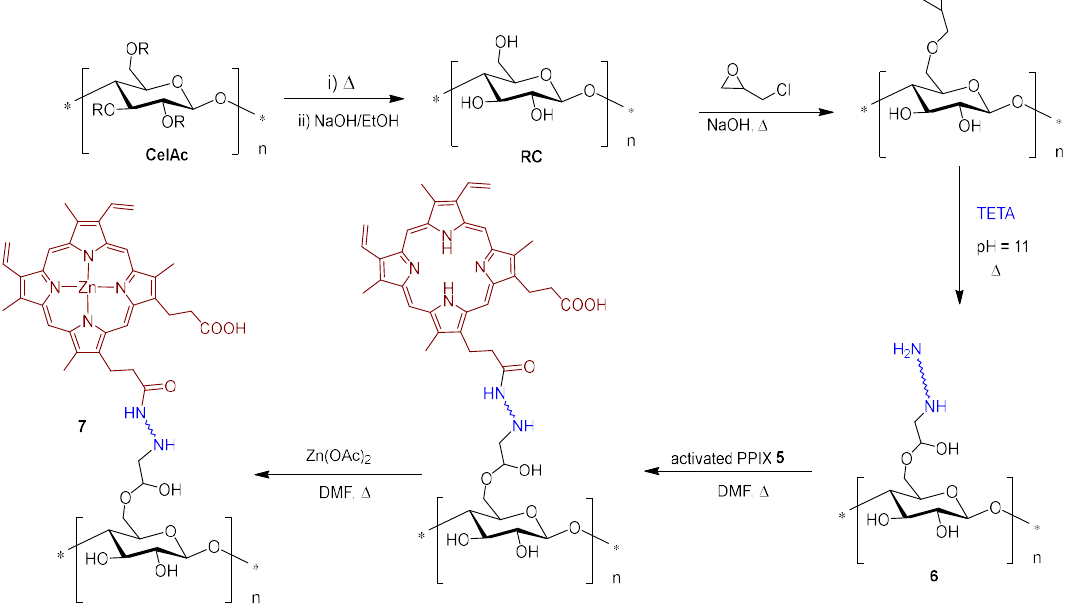
Figure 6. Covalent grafting of activated PPIX 5 using epichlorohydrin functionalized cellulose nanofibers 6 (adapted from Ref. [139] ).